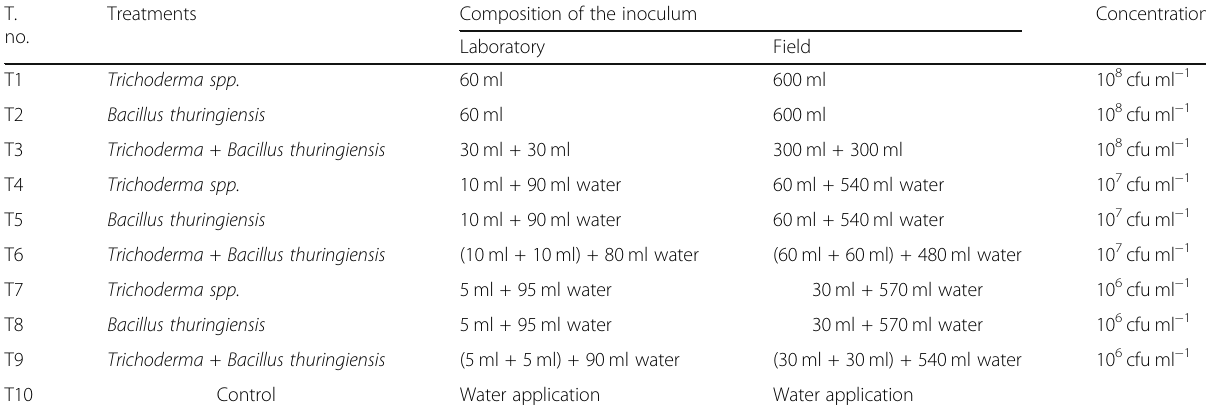
Table 1 Treatments and their details for leaf dip bioassay in laboratory and potted plant bioassay in open field conditions T. no.